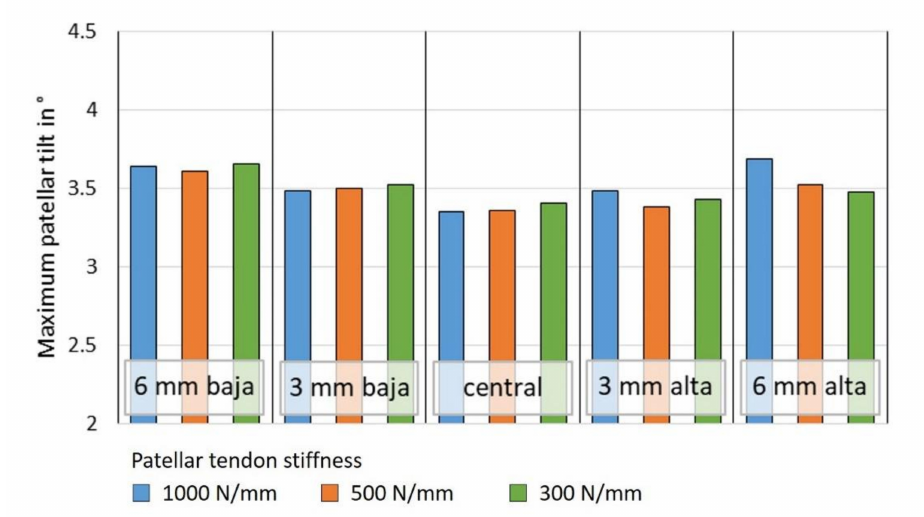
Figure 10. Peak values of the patellar tilt during weight-bearing squat for several initial patellar positions (left to right: 6 mm baja to 6 mm alta) and patellar tendon stiffnesses (blue: 1000 N/mm, orange: 500 N/mm, and green: 300 N/mm). Patellar tilt is given as rotation around the patellar proximo-distal axis. Rotations of the patella to the medial side have a positive sign.